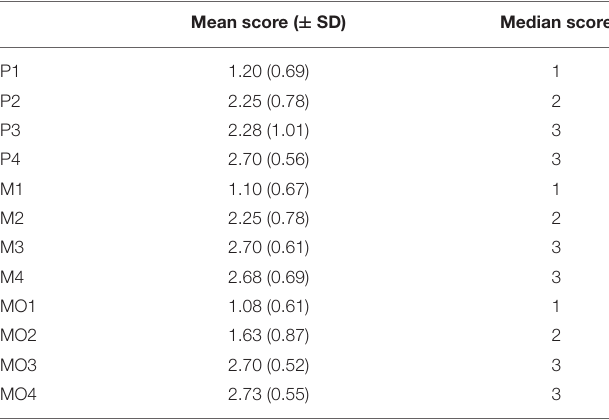
TABLE 1 | The mean ( ± standard deviation) and median scores for damage to the dura with different drilling systems and penetration depths. Mean score ( ± SD) Median